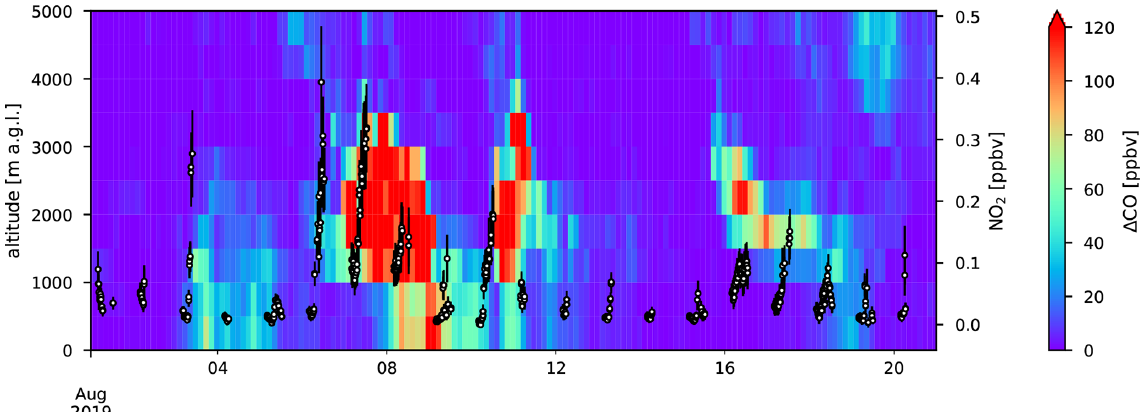
Figure A11. NO 2 (ppbv) from CU MAX-DOAS in comparison with (cid:49) CO (ppbv) from FLEXPART simulations. Altitude (ma . g . l . ) corre- sponds with vertical layers in the FLEXPART output at the location of RUN. The ground level of RUN in the model is 284ma . s . l